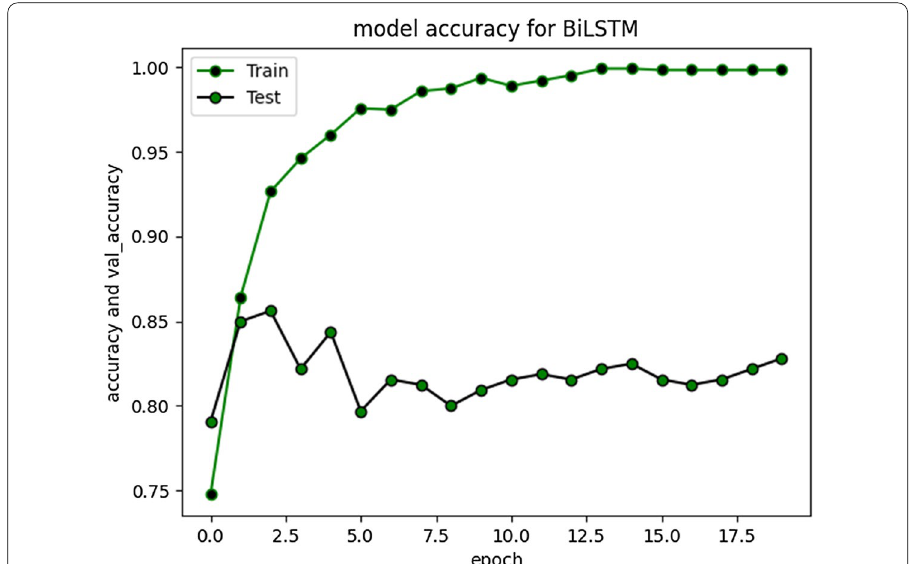
Fig. 10 RNN-biLSTM Model accuracy plot for 20 epochs